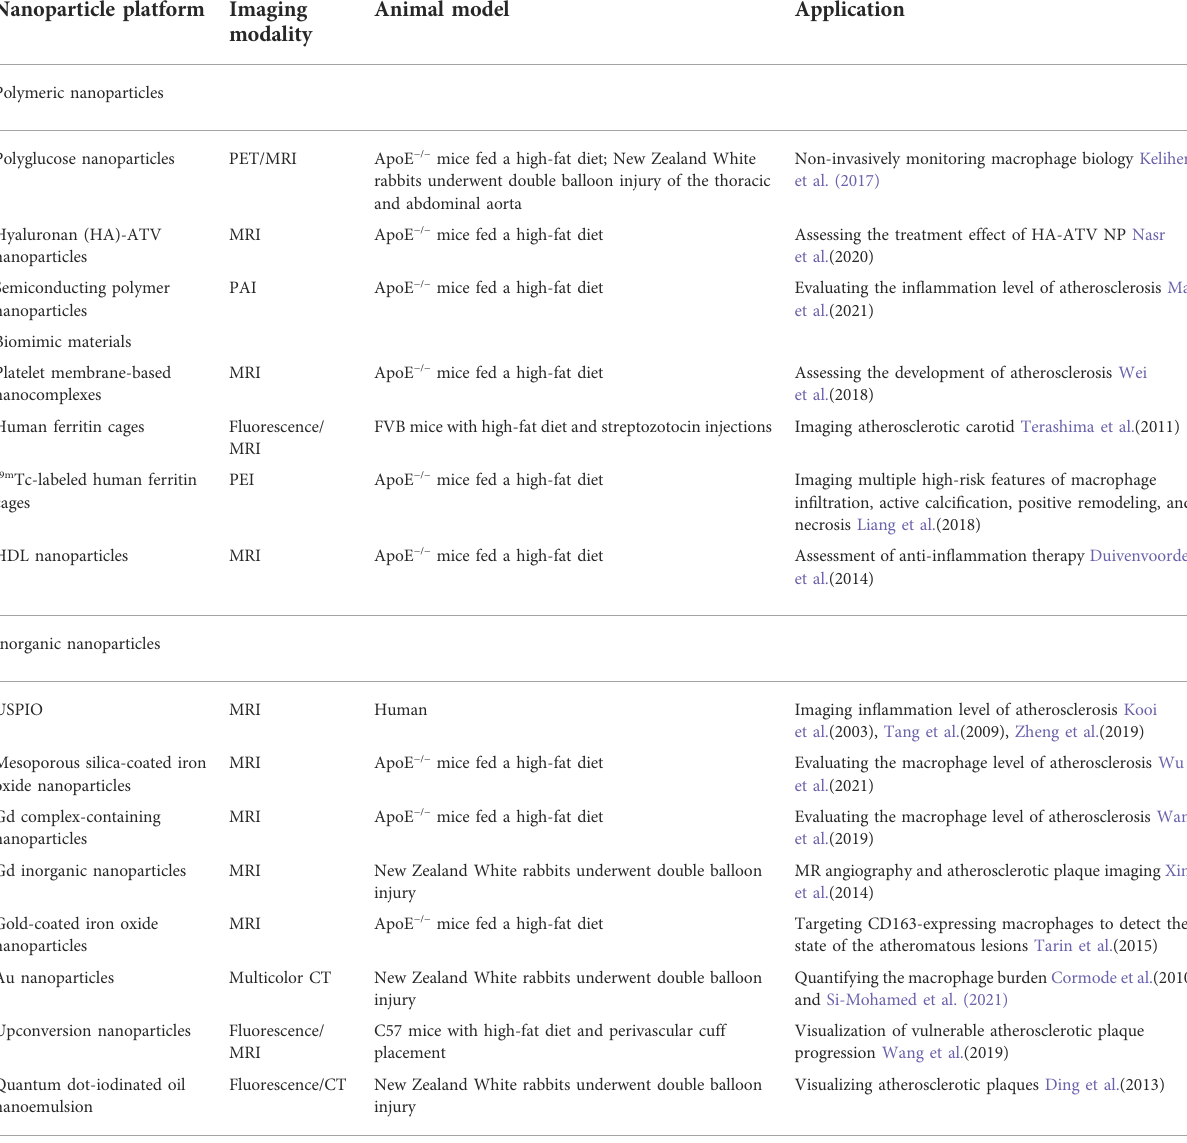
TABLE 1 Diversity of nanoparticles used in imaging of atherosclerotic